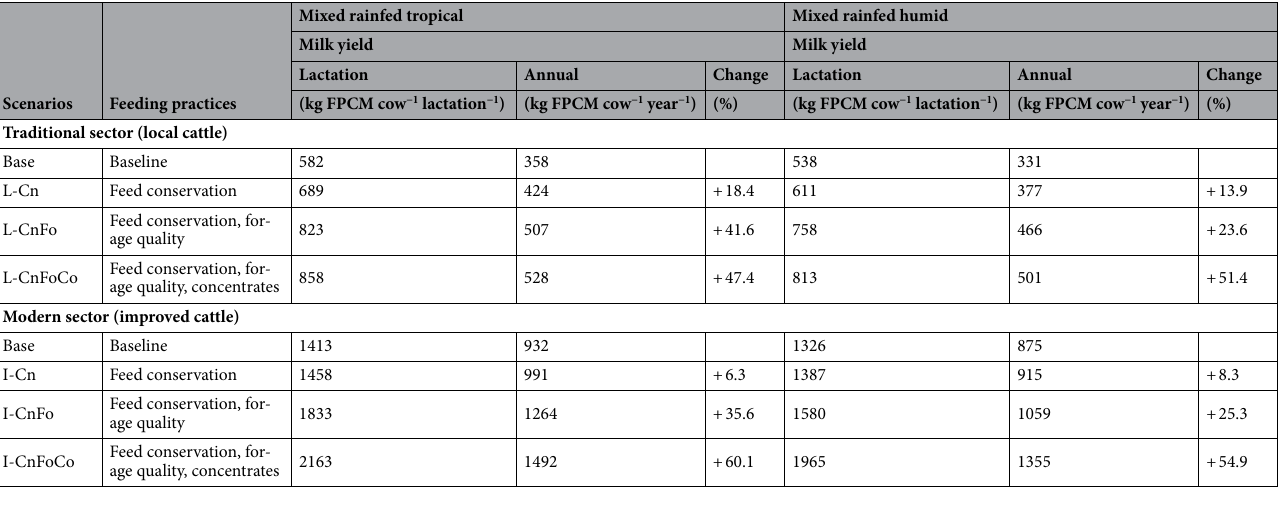
Table 3. Effects of feeding scenarios on milk yield for the Traditional sector (local cattle) and Modern sector (improved